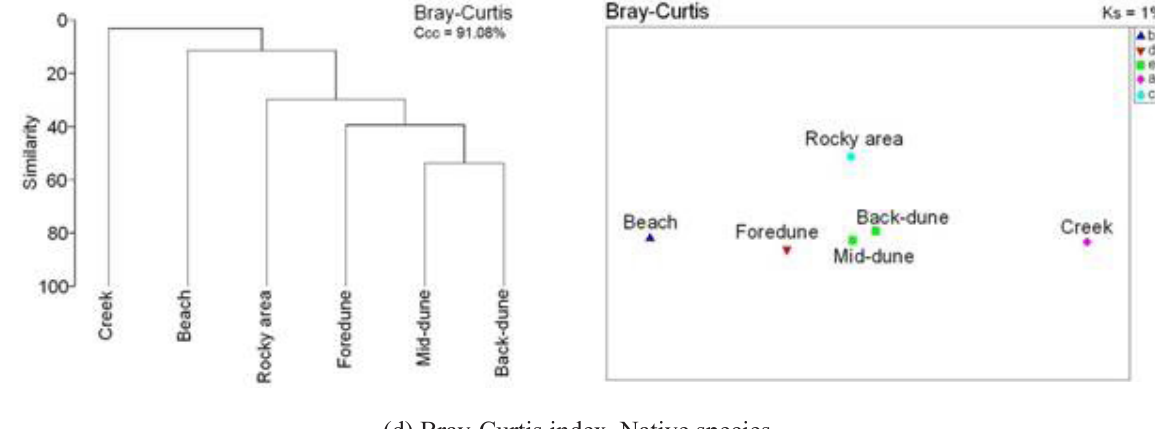
(d) Bray-Curtis index. Native species . Figure 5. Floristic similarity with and without synanthropic species. Left: Dendrograms. Right: Scatter plot graphs. Ccc - Cophenetic correlation coefficient; Ks - Kruskal’s stress